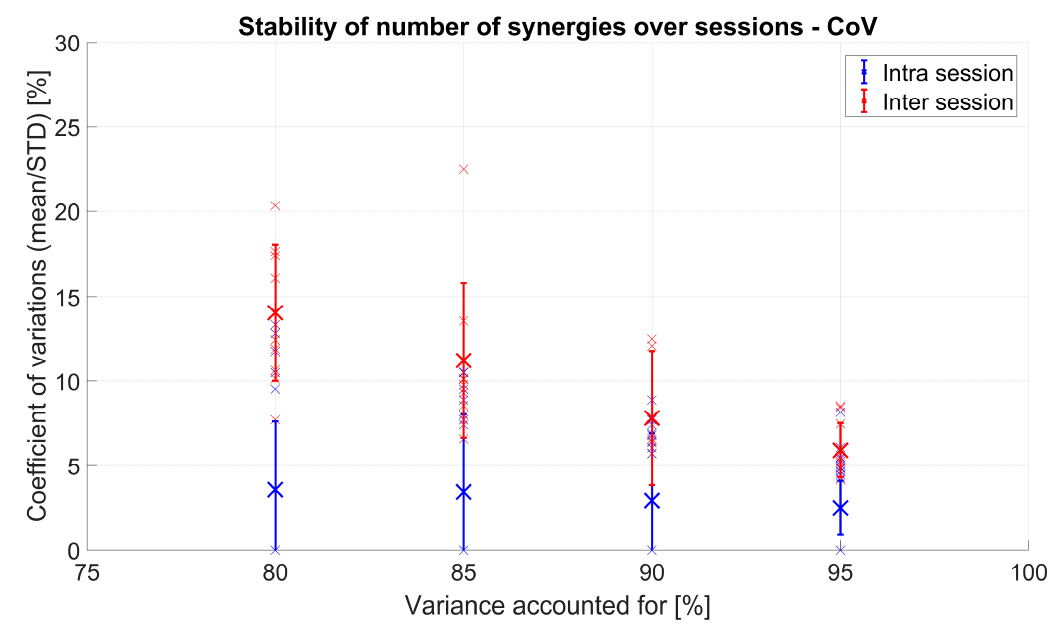
Figure 12. Intra-session (blue) and inter-session (red) CoV of NoS values for 10 subjects: Inter-session was achieved by comparing NoS values between 5 sessions of each person, whereas intra-session was achieved by comparing NoS values for 5 di ff erent movement sub-selections inside the same session (and repeated and averaged for all sessions). Each small “x” represents one person, and the bigger “X” represents the mean of all 10